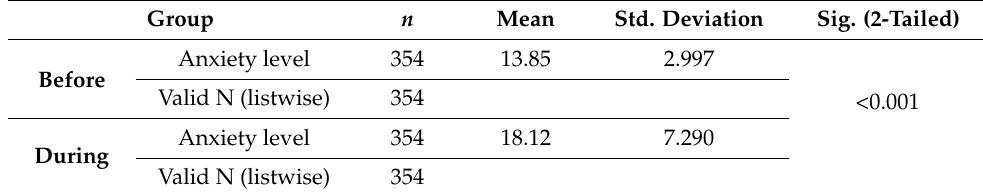
Table 3. Anxiety level before and during the lockdown